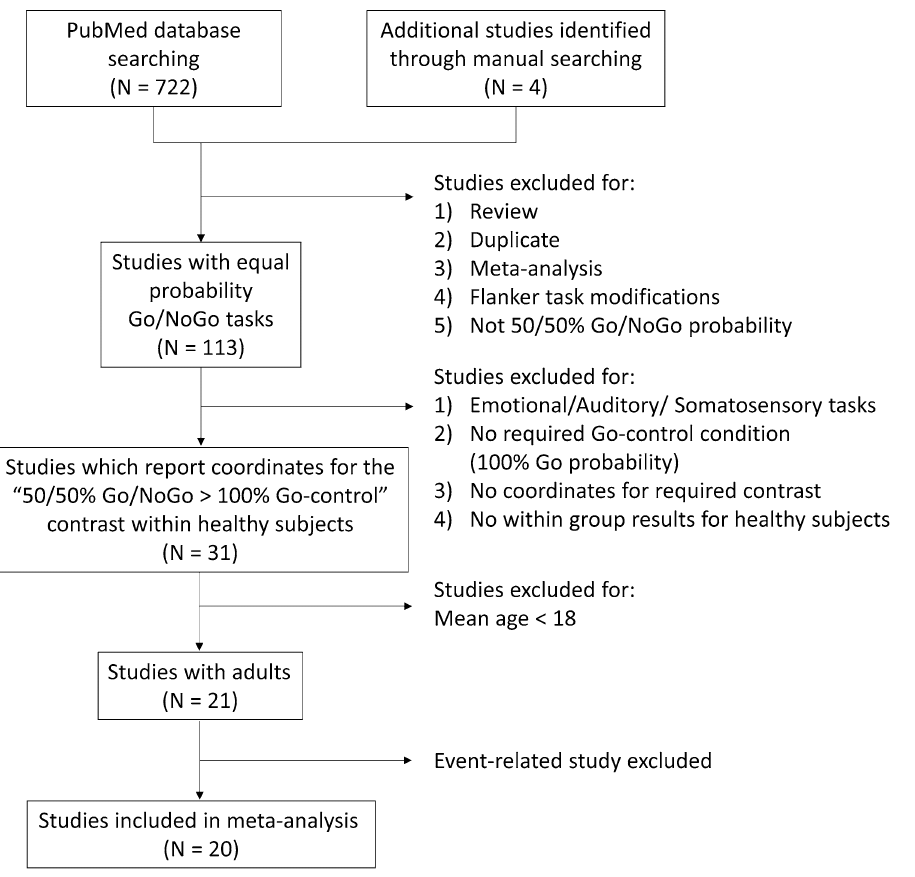
Figure 1. Flow chart of study selection in the